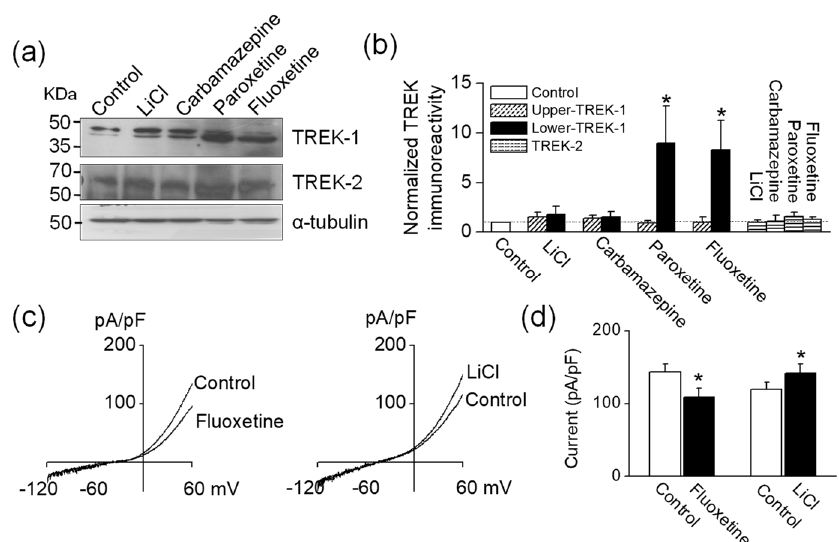
Figure 4. Effect of antidepressants and mood stabilizers on TREK channels expressing in HT-22 cells. ( a ) Western blot analysis of TREK-1 and TREK-2 in HT-22 cells treated with antidepressants and mood stabilizers. Molecular weight is indicated on the left side of the blot. In competition experiments pre-absorbed with a two-fold excess of the antigenic peptide, no signals were observed. ( b ) The bar graph shows normalized protein levels of TREK-1 and TREK-2 in HT-22 cells treated by LiCl, carbamazepine, paroxetine, and fluoxetine. The expression levels were normalized to α -tubulin. Each bar represents the mean ± SD of six experiments. ( c ) Whole-cell current tracings show the effect of fluoxetine and LiCl in HT-22 cells. ( d ) Each bar represents the mean ± SD of 13 patches. Asterisk (*) indicates a significant difference against the control without application of drugs ( p < 0.05).